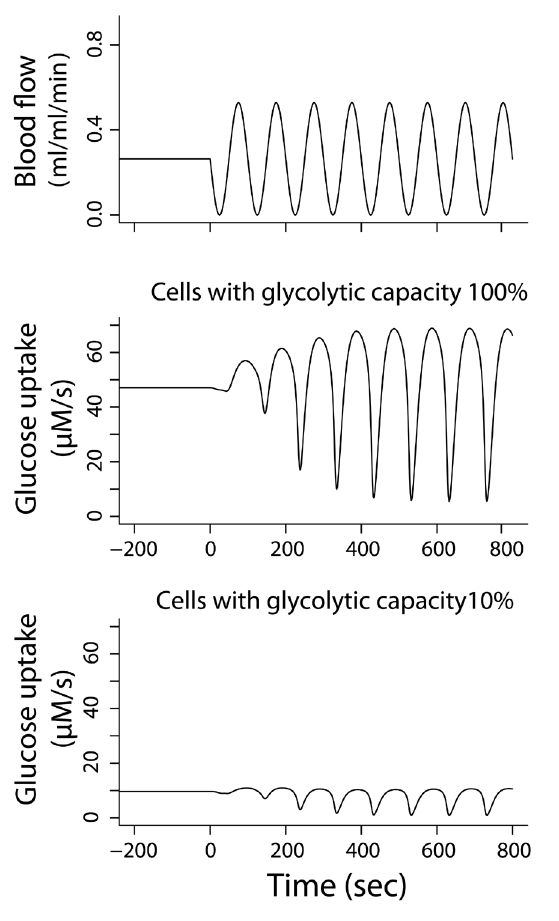
Figure 5. Simulation result of glucose uptake during constant and fluctuating blood flow. Same simulations as in Figure 4. Before t=0, when blood flow is constant, the cells at the full tumor glycolytic capacity show high glucose uptake (the Warburg effect), while cells with glycolytic capacity reduced to 10% show lower glucose uptake although they still excrete lactate at a higher rate than normal cells. When blood flow fluctuations start, the cells with high glycolytic capacity increase glucose uptake during the high blood flow periods and even increase average glucose uptake slightly. The cells with reduced glycolytic capacity show reduced average glucose